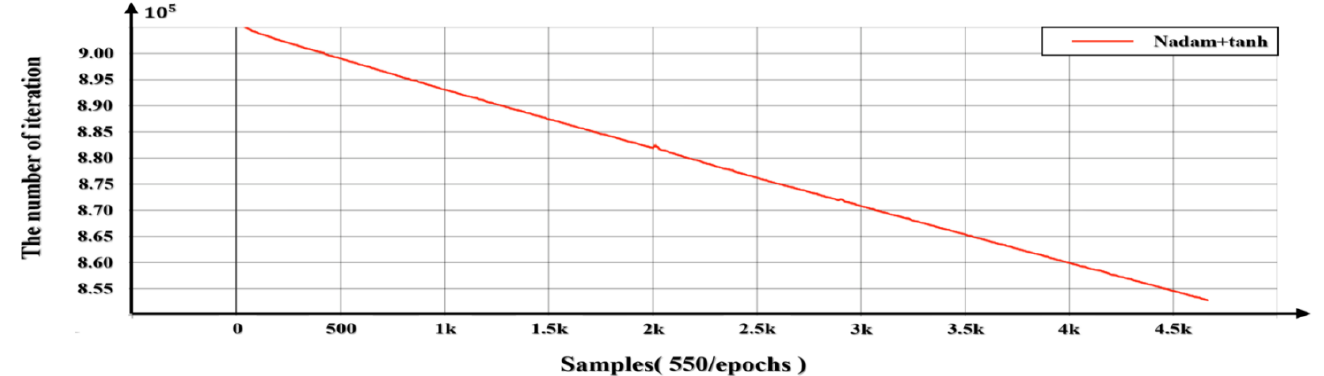
Figure 11. The loss function curve of Nadam+tanh solution method.